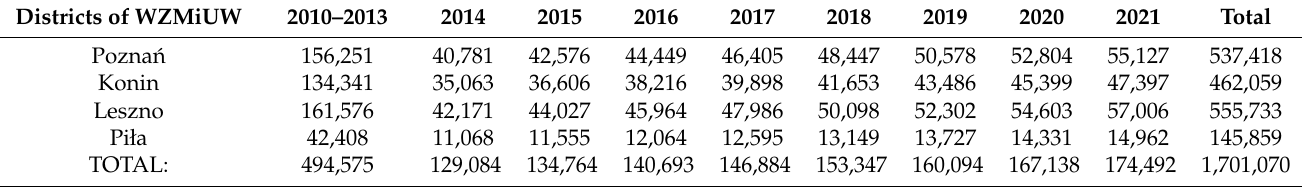
Table 3. Savings (in PLN~0.22 € ) resulting from changes in tariffs on the analyzed facilities according to the previous administrative division of WZMiUW (the forecast years are marked in